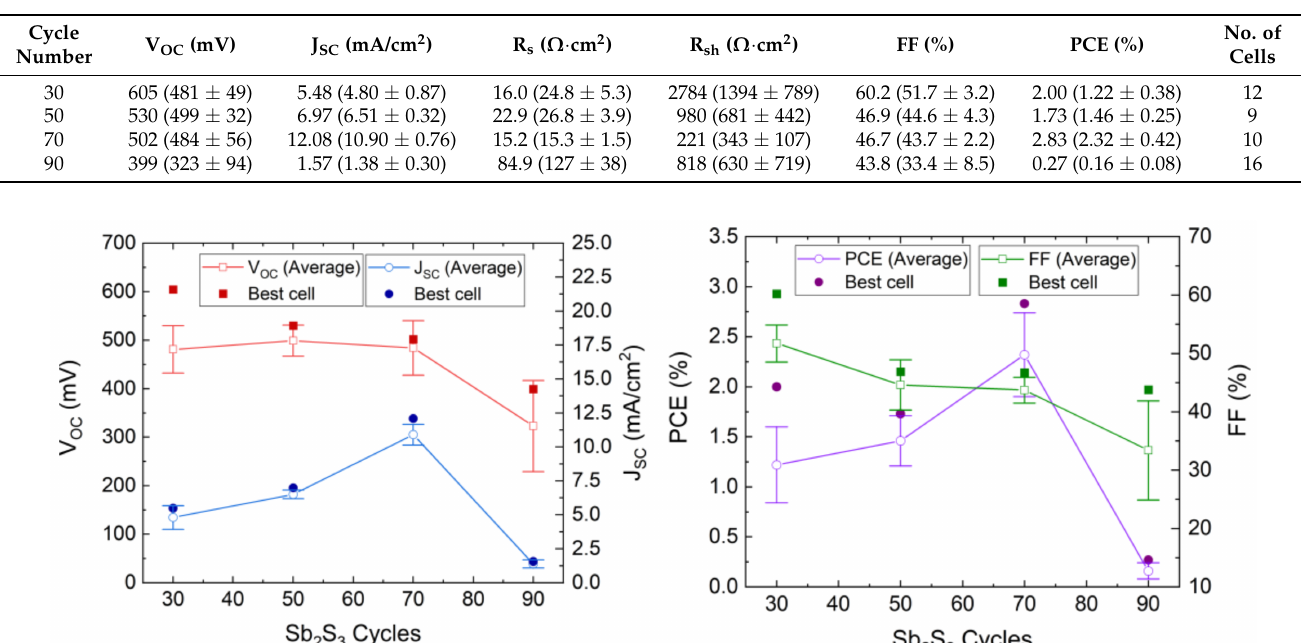
Table 1. Photovoltaic properties of the ETA solar cells involving ZnO/TiO 2 core–shell NW het- erostructures covered with a Sb 2 S 3 shell grown by CSP, using 30, 50, 70, and 90 cycles. The mean values and standard deviations are given in brackets.